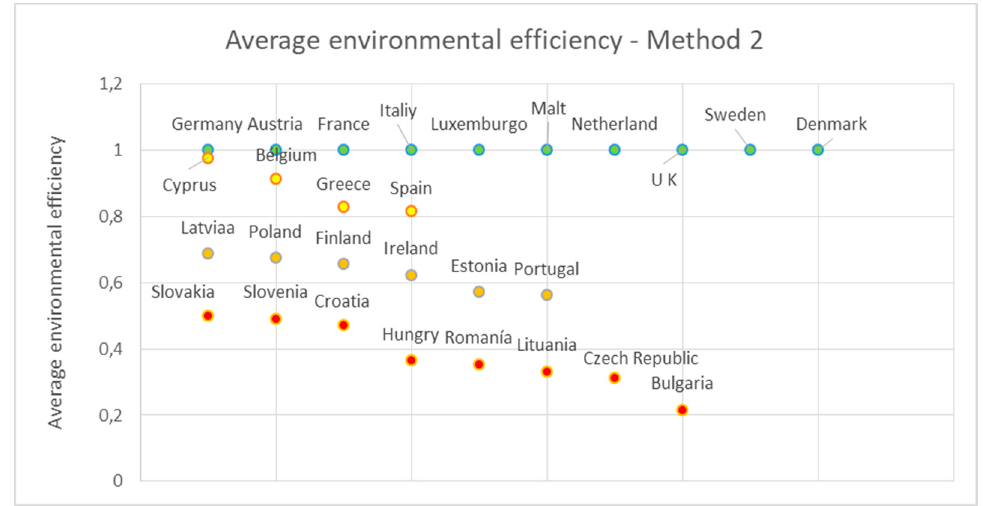
Figure 2. Average environmental efficiency of the 28 countries obtained with the DEA 2 Method classified by categories. Source: self